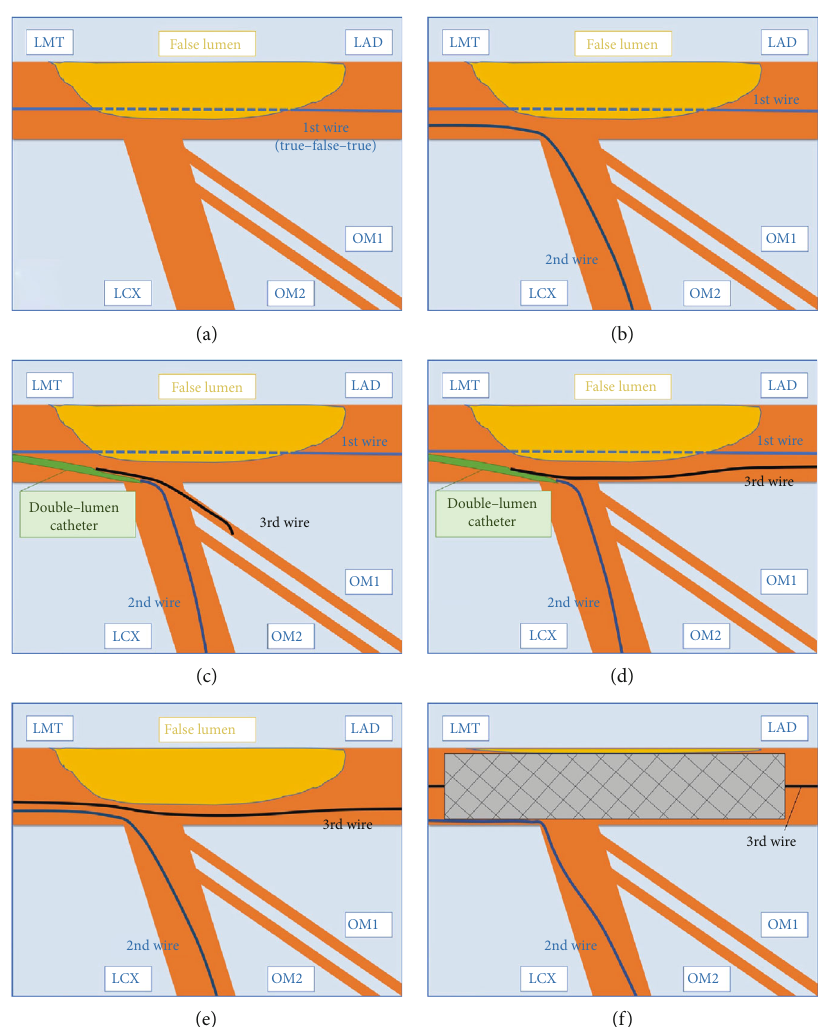
Figure 2: The scheme of the percutaneous coronary intervention. (a) The fi rst guide wire passed through the false lumen from the midportion of the LMT to the proximal site of the LAD. (b) The second guide wire was inserted into the true lumen of the LCX. (c) The third guide wire was initially introduced into the true lumen of the obtuse marginal branch using a double-lumen catheter that was placed in the true lumen of the LCX. (d) We pulled the third guide wire back and controlled it toward the true lumen of the LAD, which was located under the fi rst guide wire from the right anterior oblique and caudal view. (e) After the successful rewiring, the fi rst guide wire was removed. (f) A drug-eluting stent was deployed from the LMT to LAD. LMT: left main trunk; LAD: left anterior descending artery; LCX: left circum fl ex artery; OM: obtuse marginal